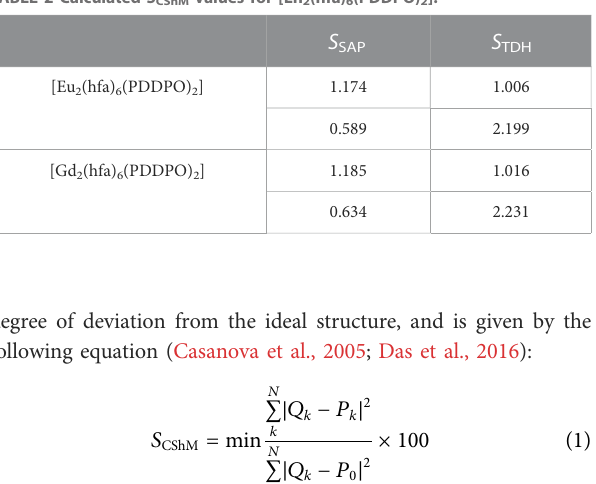
TABLE 2 Calculated S CShM values for [Ln 2 (hfa) 6 (PDDPO) 2 ].